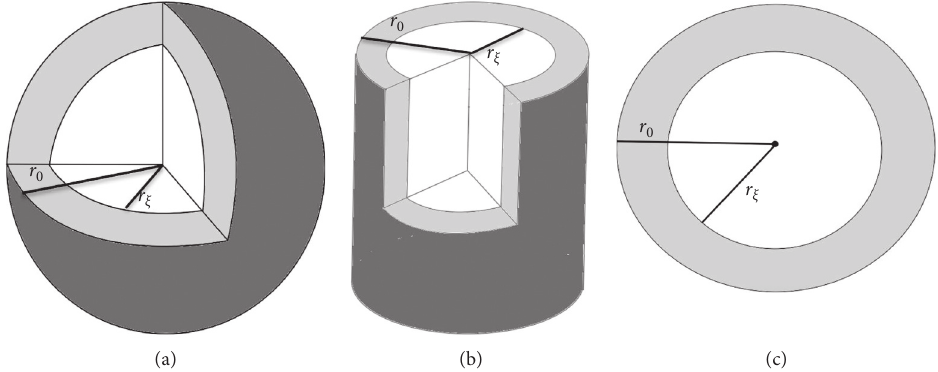
Figure 5: Schematic representation of inward solid-state diffusion with phase change in a cylinder and a